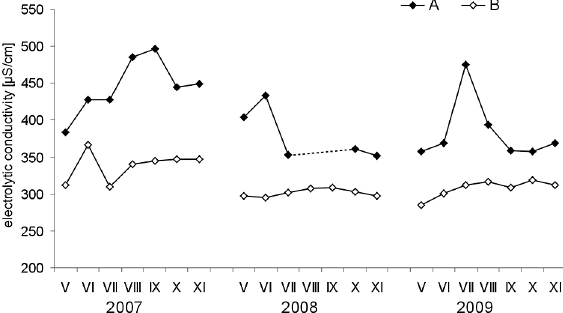
Fig. 4. Changes of groundwater electrolytic conductiv- ity in marginal zone (A) and bed-adjacent zone (B) of the Chwiszczej river valley in the years